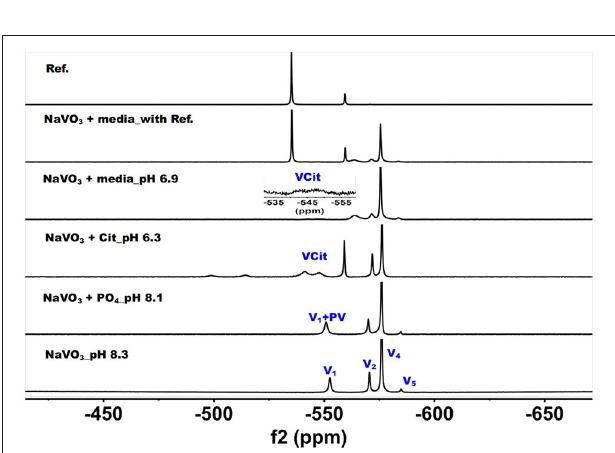
FIGURE 3 | 51 V NMR (78.9 MHz) spectra are shown of solution of colorless oxovanadate (40mM V 1 , 40mM V-atoms). The samples are from the bottom up diluted V 1 stock solution (40mM V-atom) at pH 8.3; 10mM V 10 in the presence of 24mM P i at pH 8.1; 10mM V 10 in the presence of 0.48mM citrate at pH 6.3, and finally 10mM V 10 in the presence of Middlebrook 7H9 broth medium supplemented with 10% ADC enrichment (5% BSA, 2% dextrose, 5% catalase), glycerol (0.2%, v/v) and Tween 80 (0.05%, v/v) recorded both in the absence and the presence of a capillary reference of 100mM Na 3 VO 4 . The spectrum labeled Reference is of the capillary reference alone (top spectrum). The key to the signals: V-oligomers, V 1 monomer; V 2 , dimer; V 4 , tetramer; V 5, pentamer; VCit, V-citrate complex; PV, vanadate-phosphate complex.